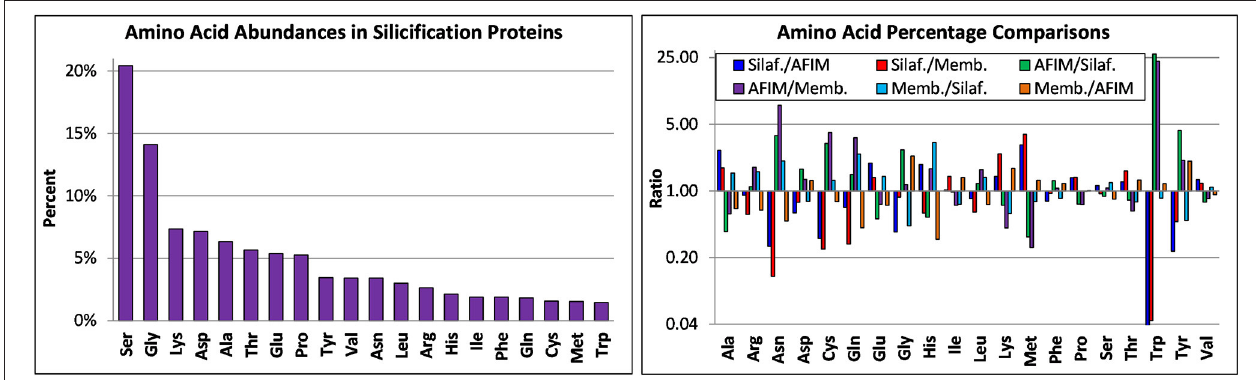
FIGURE 10 | Amino acid composition of silicification proteins based on analysis of their published sequences. Top, amino acid abundances of all proteins, bottom, ratio of amino acid abundances for different classes of proteins, including silaffins (Silaf), those associated with the AFIM (AFIM), and the SDV membrane or silicalemma